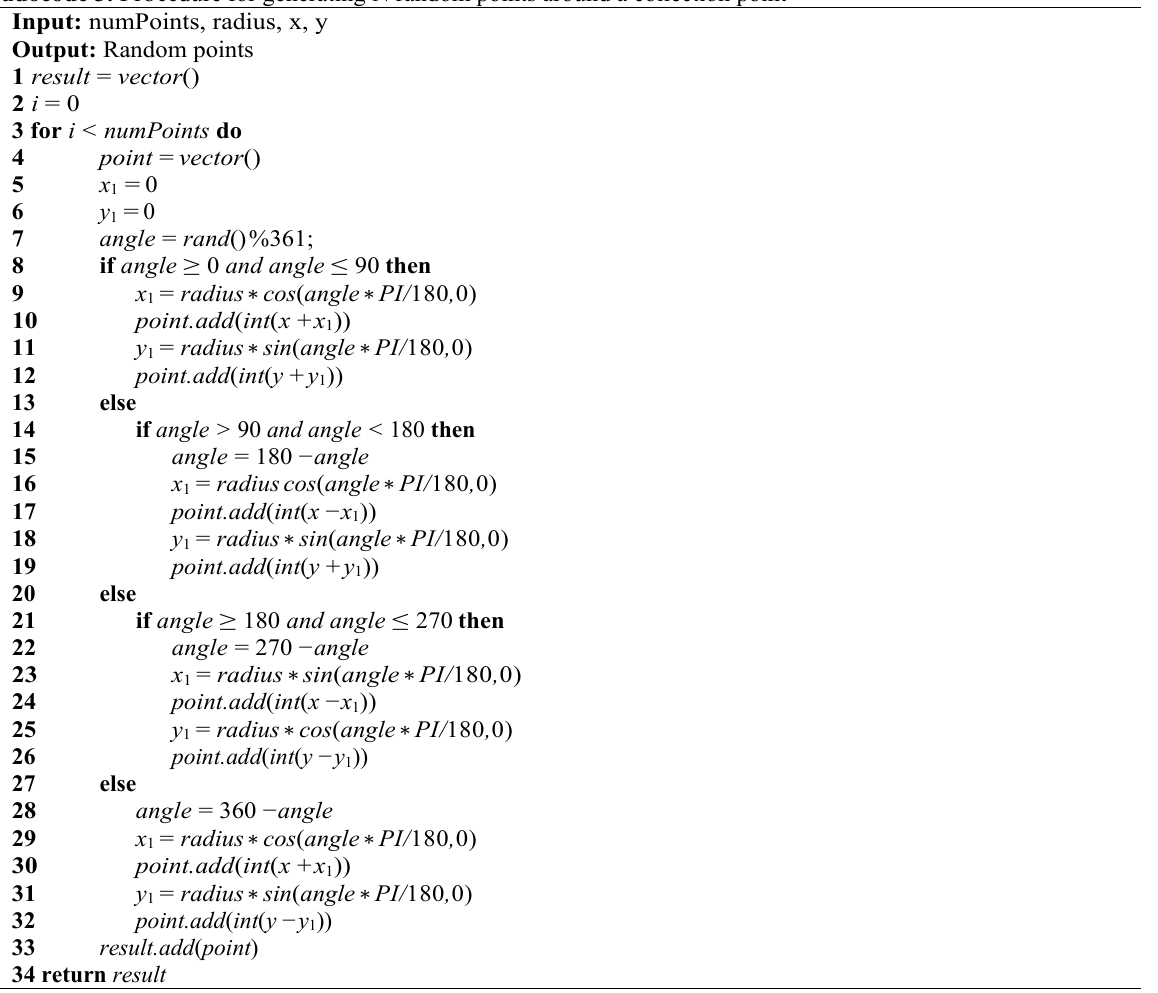
Pseudocode 3. Procedure for generating N random points around a collection